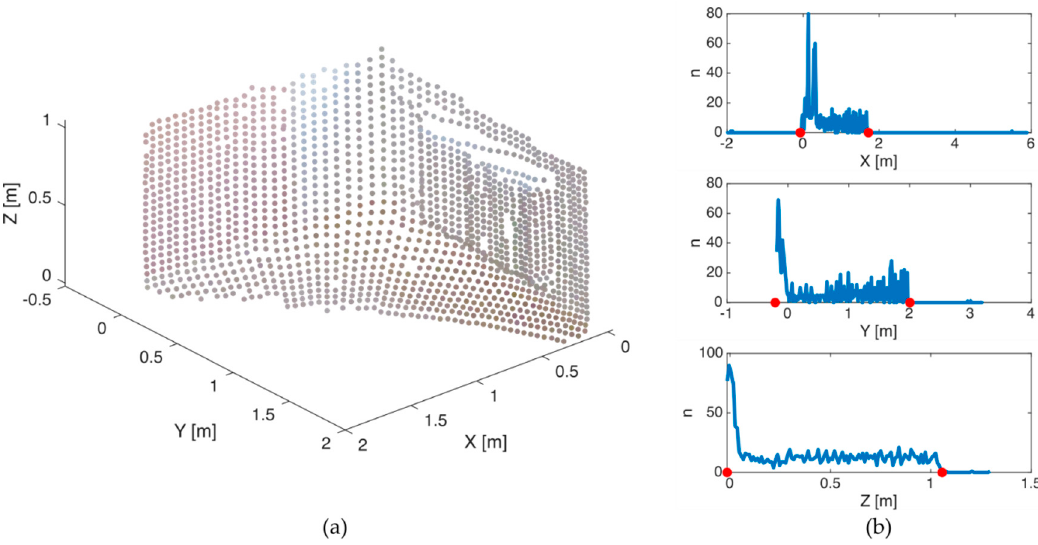
Figure 4. Removal outliers result: ( a ) Resultant point cloud; ( b ) New range of histograms.